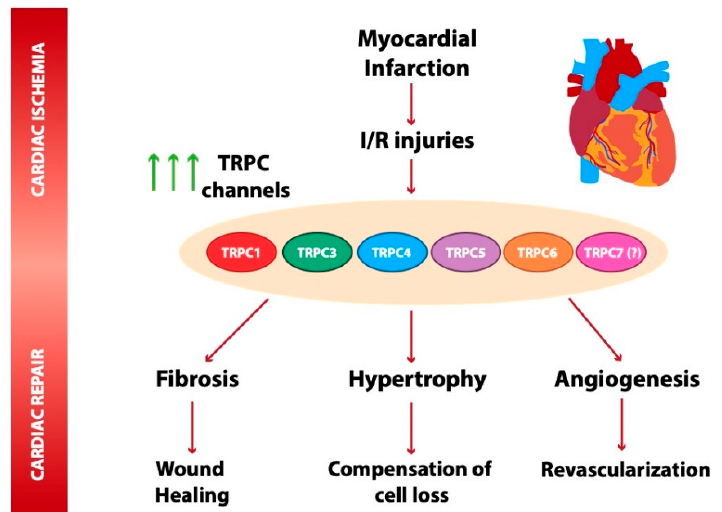
Figure 1. Scheme summarizing transient receptor potential canonical (TRPC) channel isoforms dysregulated under myocardial infarction (MI) and ischemia and reperfusion. TRPC1, 3, 4, 5, and 6 are upregulated in mouse and rat animal models of MI [5,13,71]. Compelling evidence indicates that TRPC channel overexpression contributes to Ca 2 + entry, mediating the activation of Ca 2 + -sensitive signaling pathways, such as calcineurin–NFAT, a critical pathway involved in apoptosis, cardiac hypertrophy, and fibrosis [13,28,55,66,67]. TRPC proteins are likely also involved in cardiac repair-related processes. The protective role played by TRPC6 in wound healing is of note [37]. Other studies suggested a role of TRPC channels, such as TRPC5, in angiogenesis and revascularization triggered post ischemia [104].